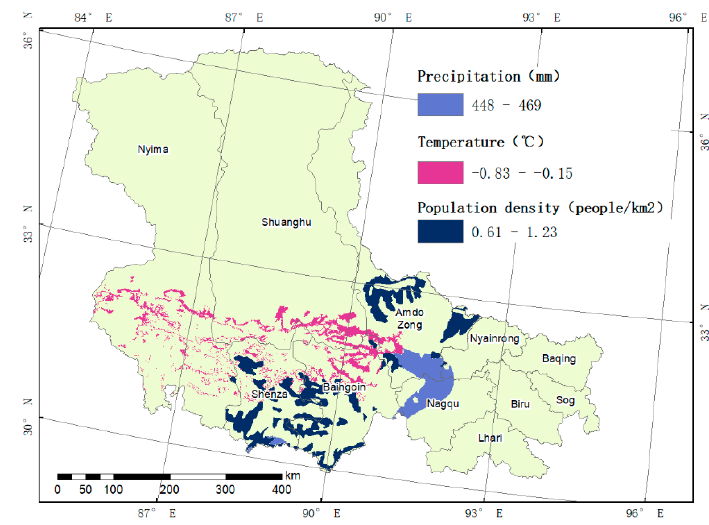
Figure 8. Areas vulnerable to vegetation degradation in different vegetation types. The areas in royal blue, purple and dark blue represent the alpine meadow, the alpine scrub and the alpine steppe, respectively. The risk detector can detect the areas with high degradation risk by comparing vegetation degradation levels in different ranges of influence factors. To avoid spatial overlap and identify risky areas, in each vegetation type, we have selected the most contributing factors to vegetation degradation.